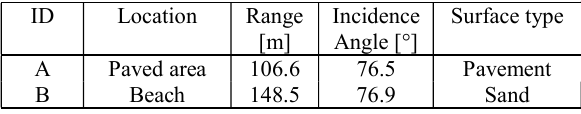
Table 2. Locations and respective properties used to assess tem- porally variable measurement